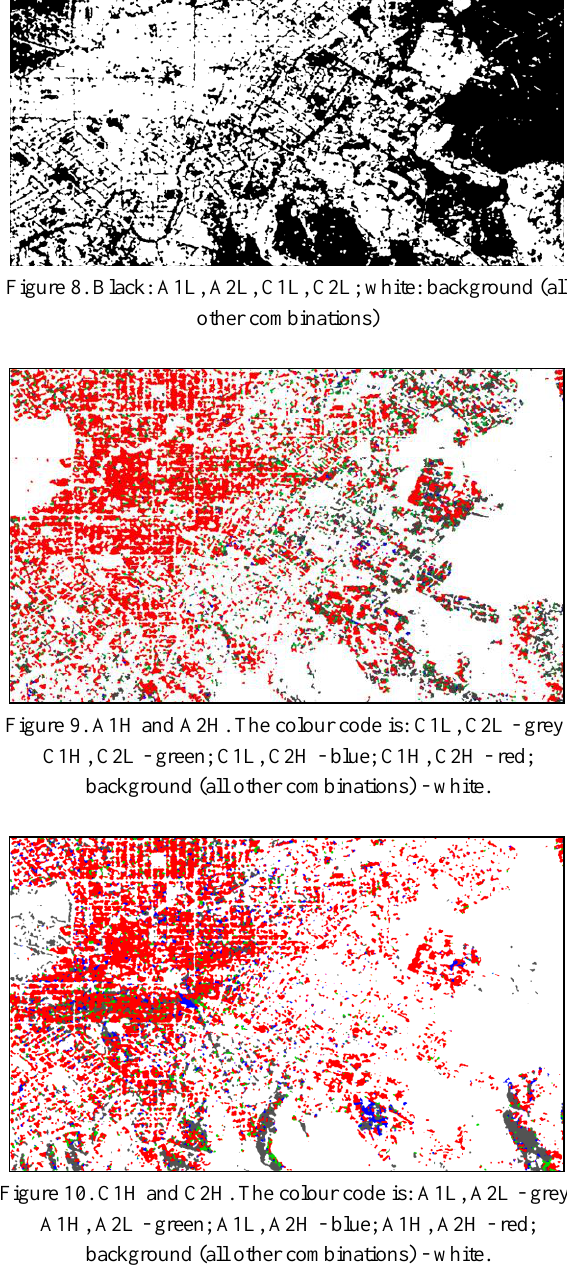
Figure 13. Positions of six randomly chosen points used to illustrate the validation